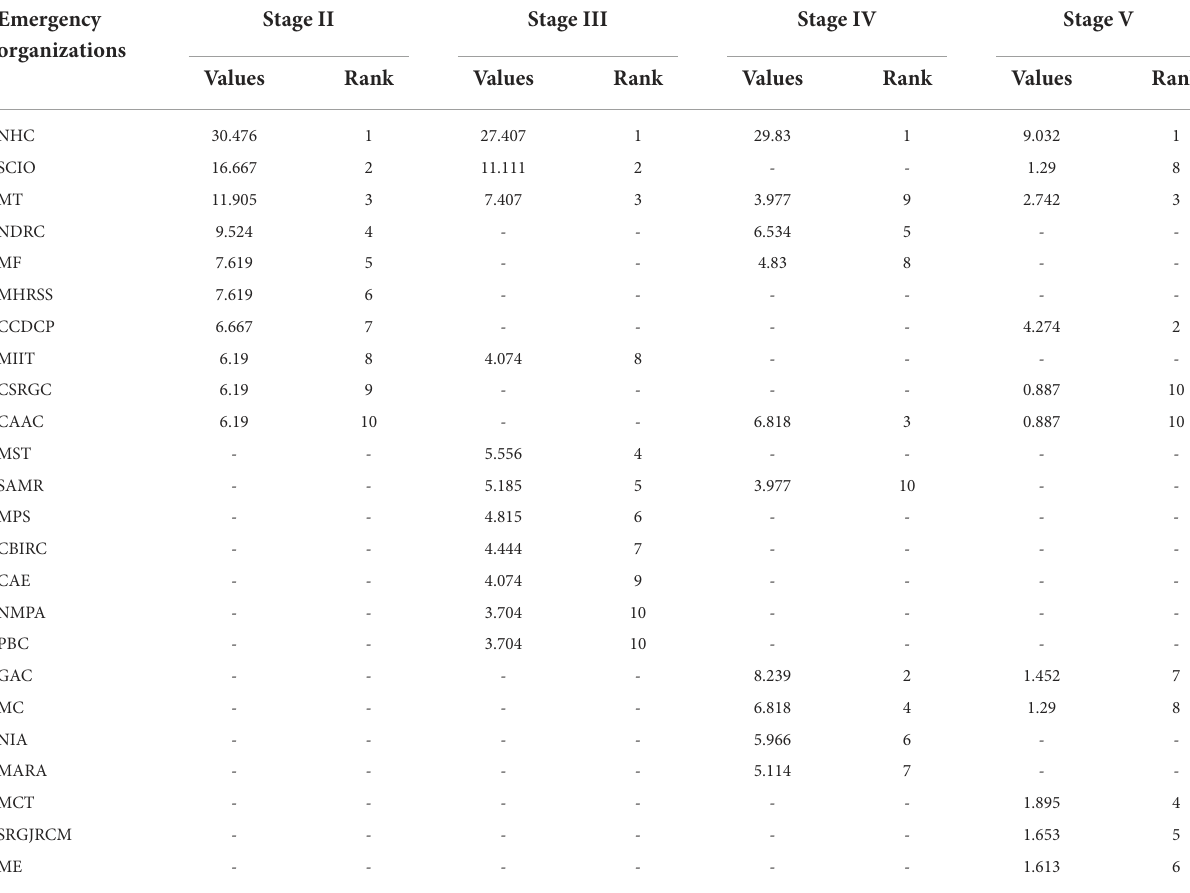
TABLE 4 Top 10 EOs with the normalized degree centrality in Stages